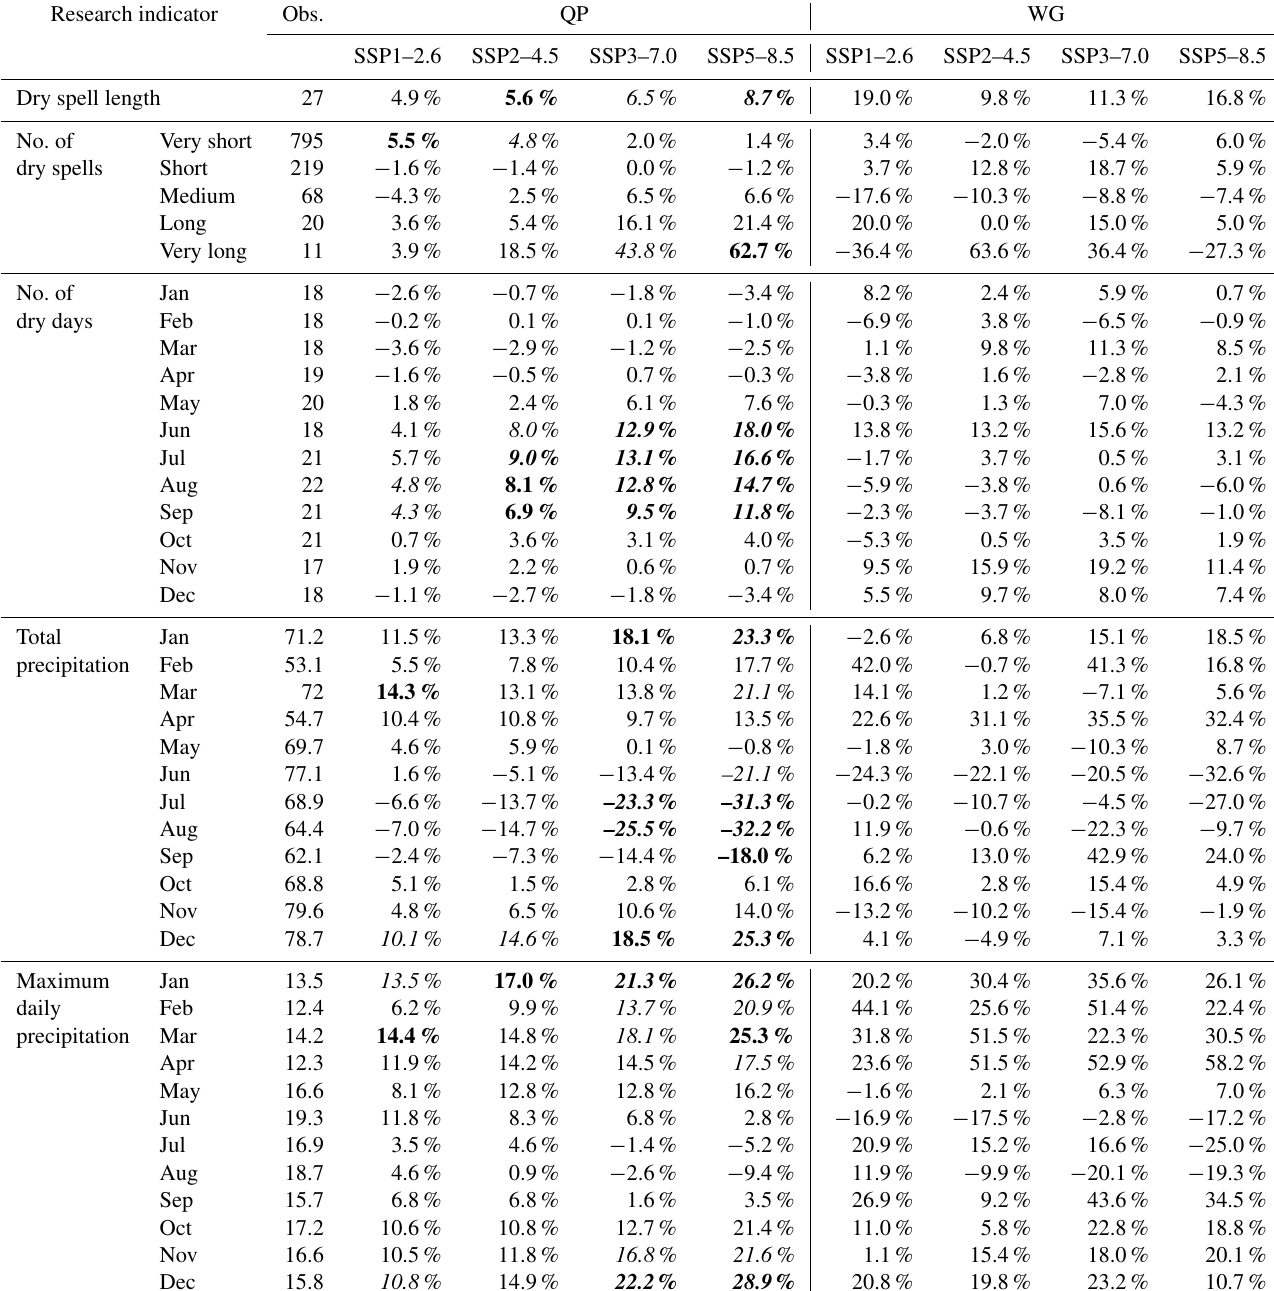
Table 6. Climate change signals for QP and WG and the corresponding significance for QP. Significance testing is not possible for WG as it does not downscale each member of the ensemble separately. The climate change signal is the change relative to the historical observations (1971–2000). Numbers in italic, bold and bold italic denote significant changes at 20%, 10% and 5% levels,